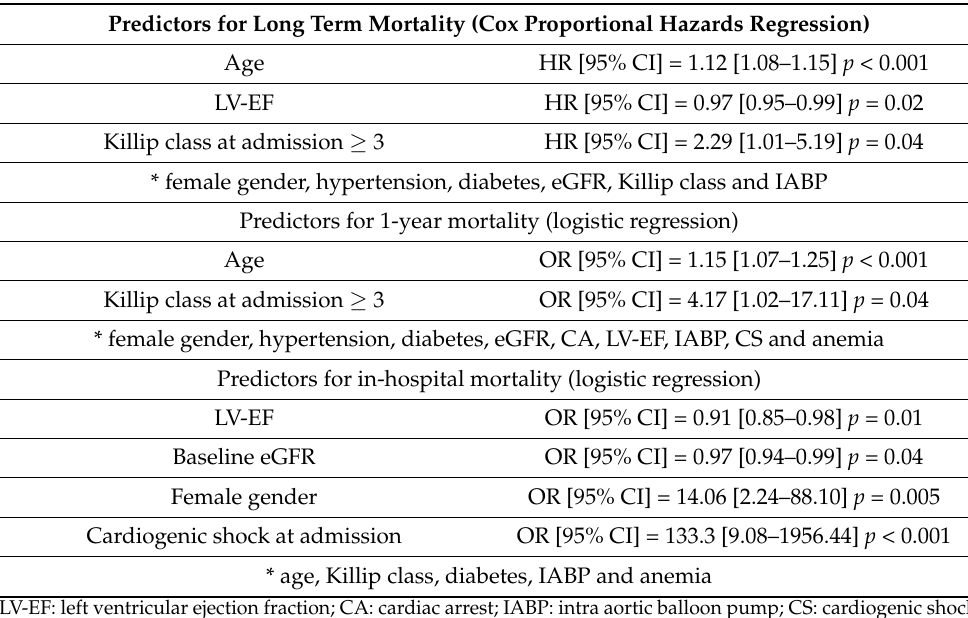
Table 2. Main independent predictors for short- and long-term mortality.